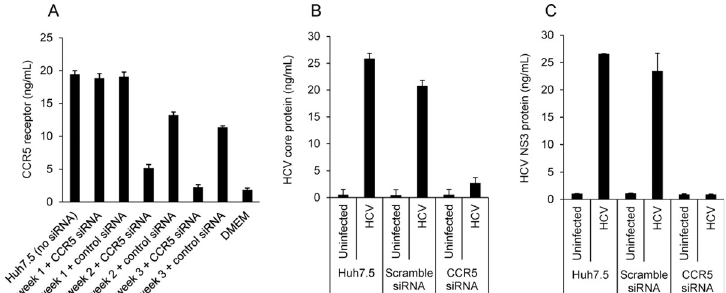
Fig 4. Effects of CCR5 knockdown. Huh7.5 cells were treated for 1–3 weeks with shRNA sequence corresponding to CCR5 or scramble to generate the Huh7.5 shCCR5 and Huh7.5 shSCRAMBLE cell lines. (A) CCR5 receptor expression was evaluated using via a cell-based ELISA. Huh7.5 shCCR5 or Huh7.5 shSCRAMBLE were plated in 24-well format and incubated with infectious virions harvested from the Huh7.5 JFH1 cell line. HCV core protein (B) was quantified in cell culture supernatants, while HCV NS3 protein (C) was quantified in cell lysates.